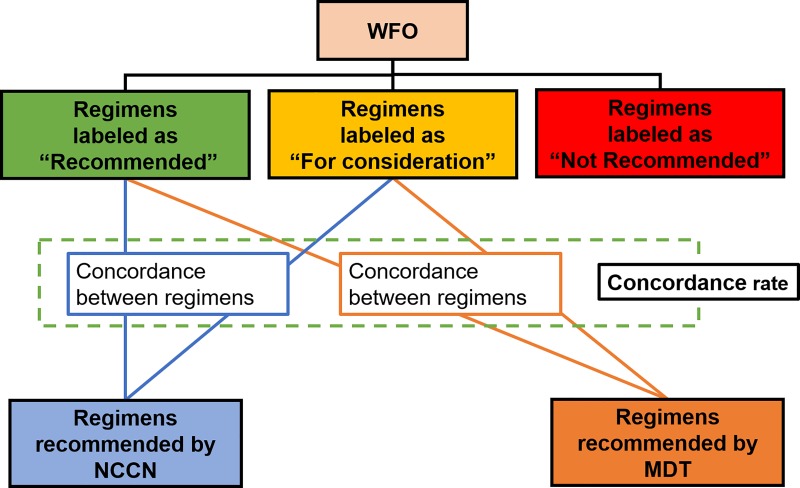
A diagram showing how the concordance between groups was measured.